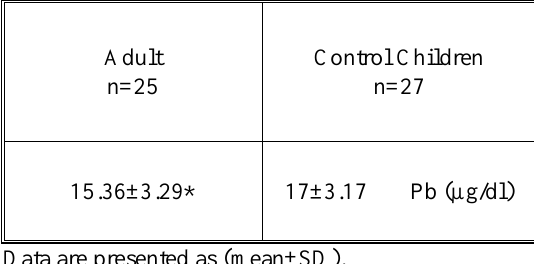
Figure (1): The blood lead levels in children